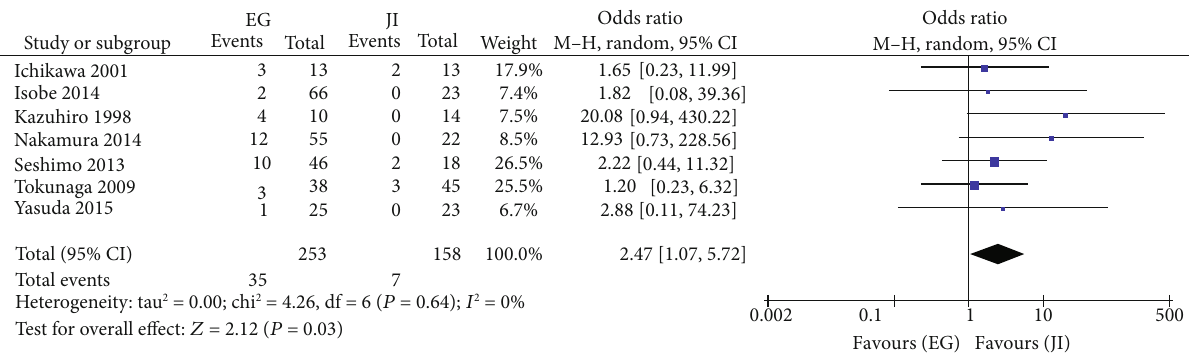
Figure 4) or publication bias ( P = 0 : 093 ). Sensitivity analyses